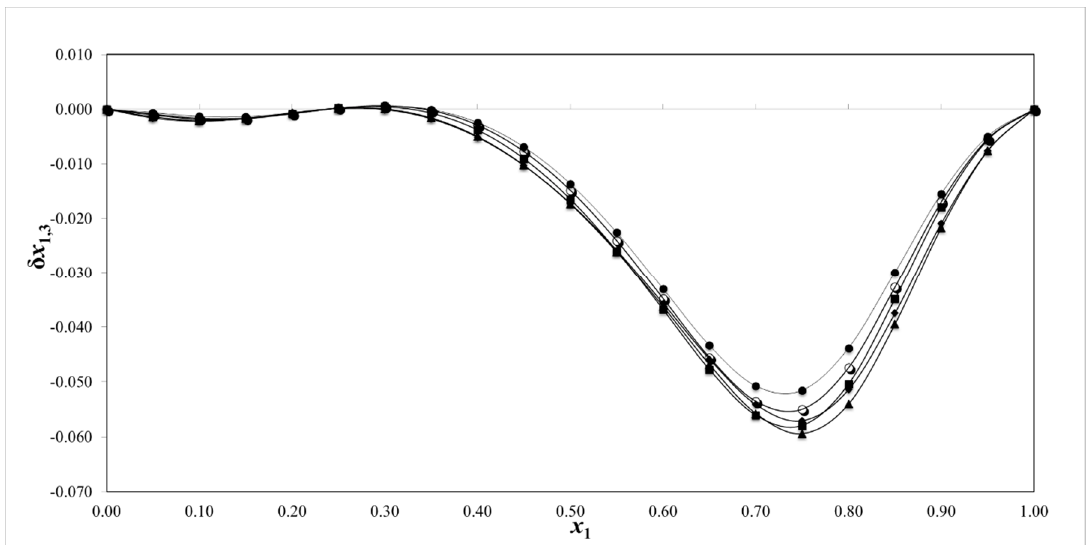
Figure 8. The δ x 1.3 values of amygdalin (3) in {ethanol (1) + water (2)} mixtures at mixtures ● : 293.15 Figure 8. The δ x 1,3 values of amygdalin (3) in {ethanol (1) + water (2)} mixtures at mixtures • : 293.15